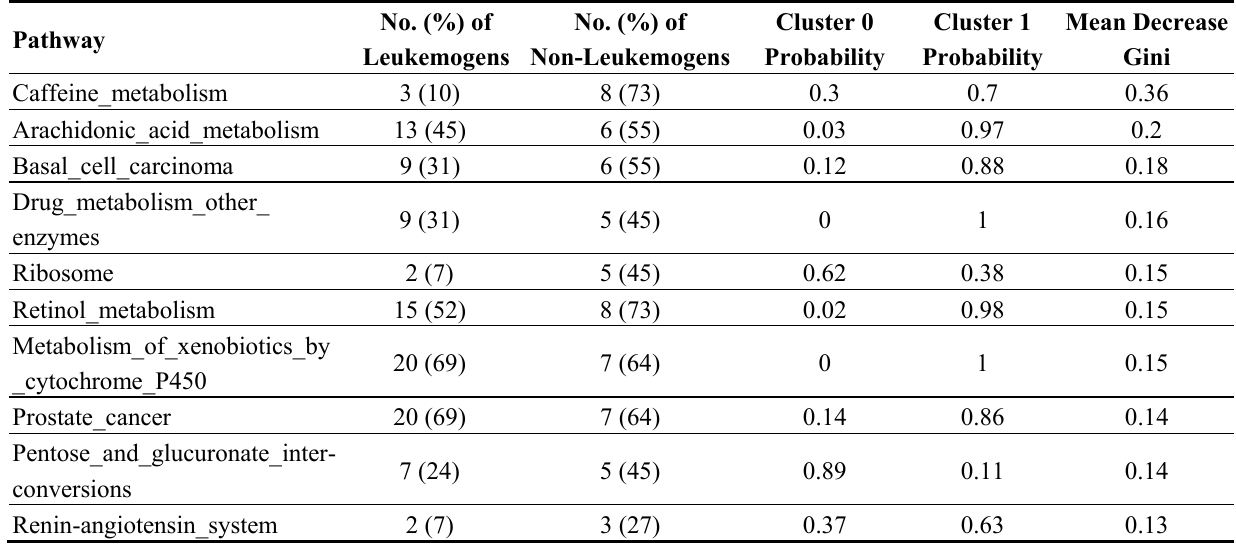
based on mean decrease in gini index scores from the random forests based